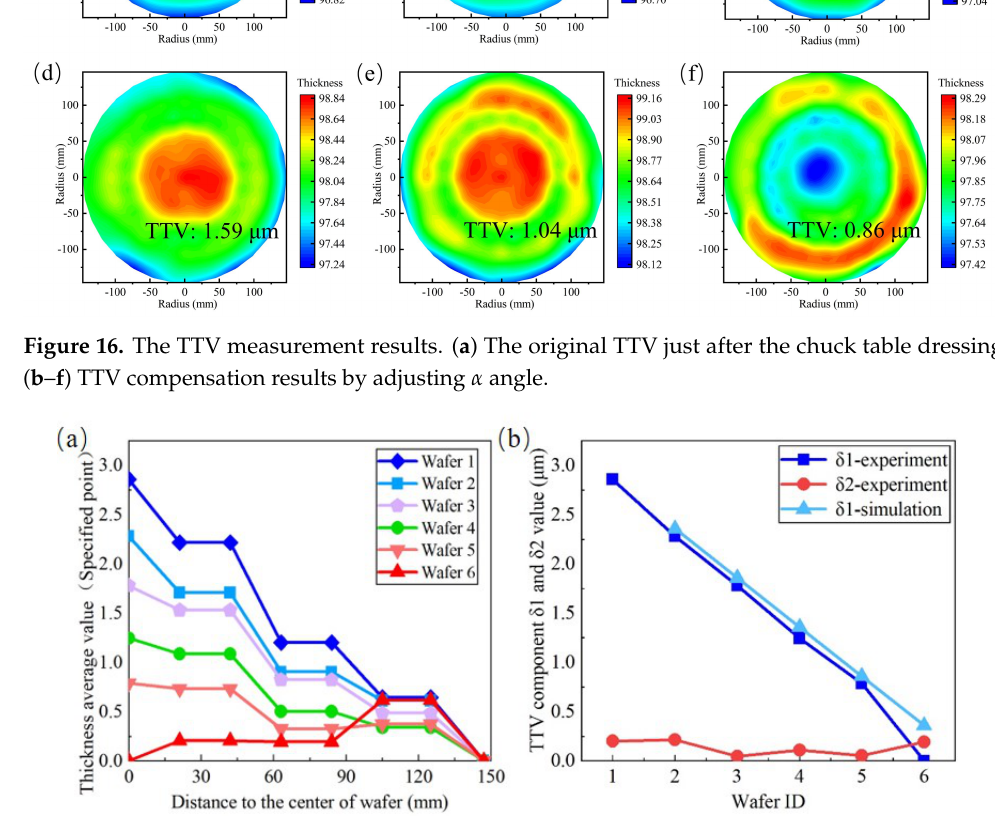
Figure 17. The quantitative analysis of TTV measurement results. ( a ) The thickness average values of points at the same radius. ( b ) The trends of δ 1 and δ 2 with the variation of α angle, and the comparison of δ 1 between the experimental and simulation